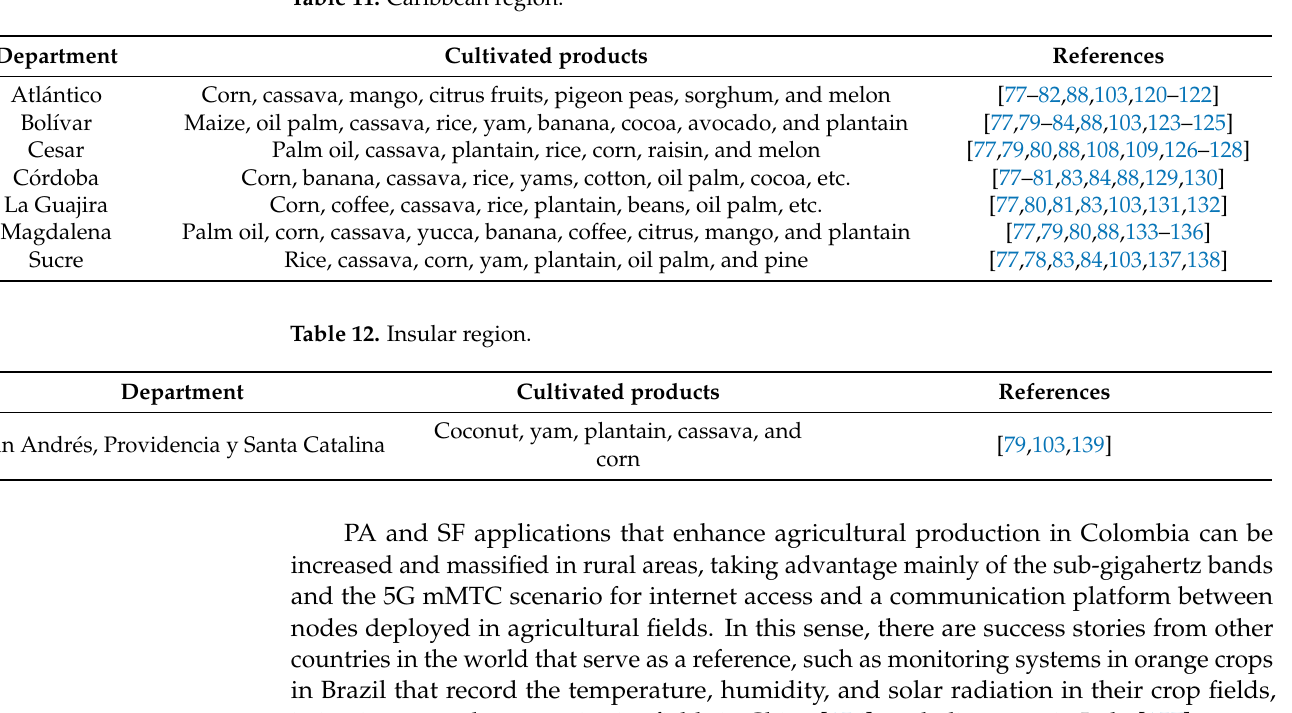
Table 11. Caribbean region.